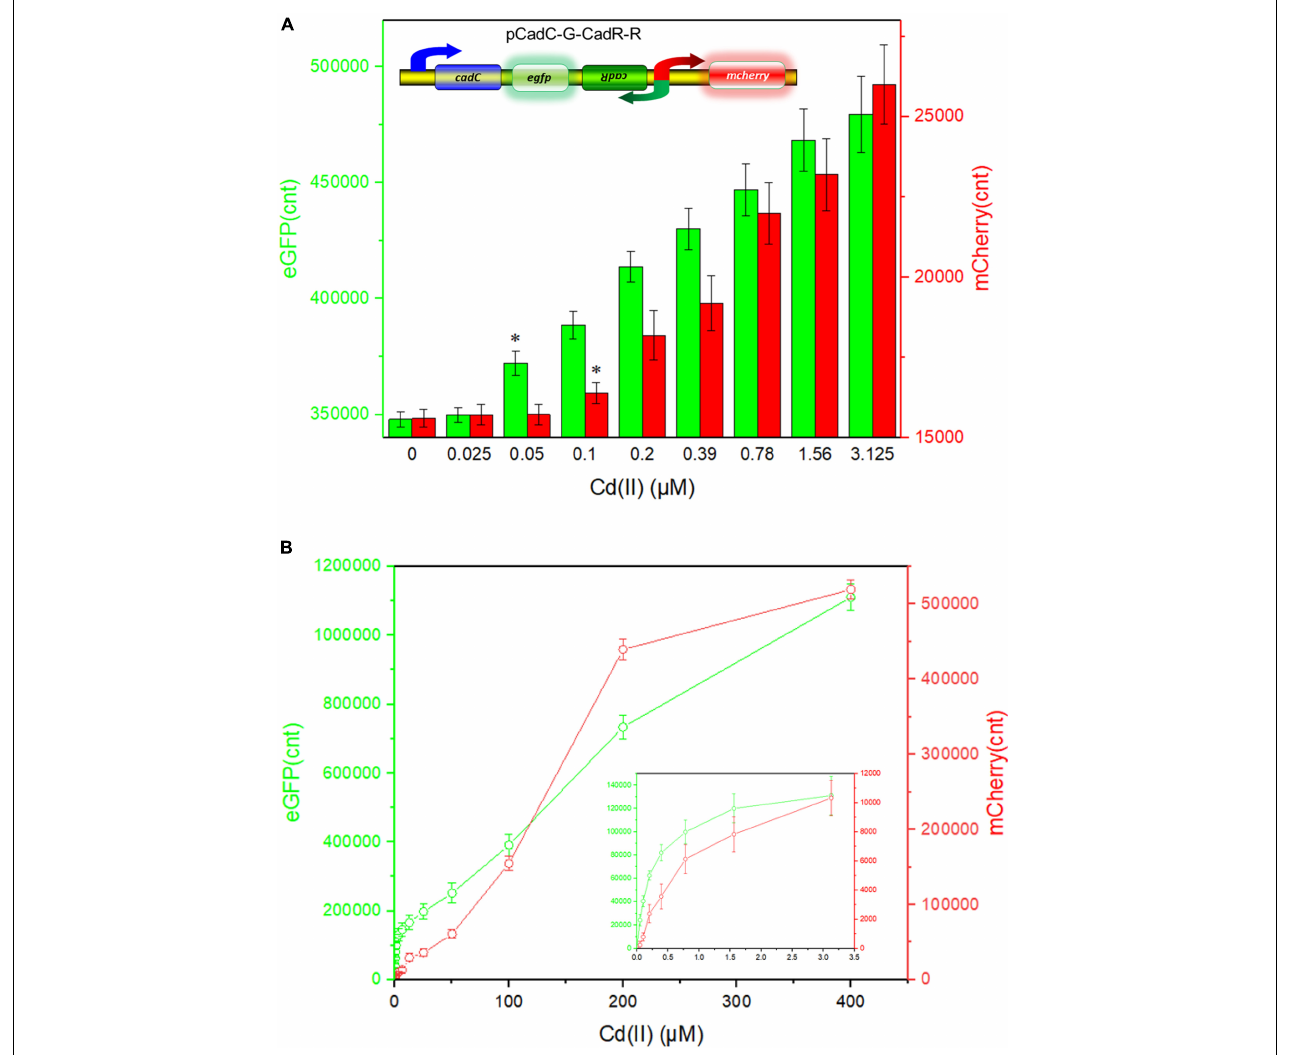
FIGURE 8 | Double-color fluorescence generated by the dual-sensing biosensor after exposure to gradient concentrations of Cd(II). Both fluorescent signals were determined after a 12-h incubation with gradient concentrations of Cd(II) at 37 ◦ C. The fluorescent signal was indicated as a fluorescence count value (unit = cnt), and fluorescence intensity values were normalized using the absorbance at 600 nm. Results are the average of at least three independent experiments performed in triplicate. (A) Detection limit of the dual-sensing biosensor TOP10/pCadC-G-CadR-R. The asterisk indicates a significant increase (two-tailed t -test, P < 0.001 for eGFP and P < 0.05 for mCherry) in fluorescent intensity, in comparison to the same biosensor exposed to 0 µ M Cd(II). (B) Response curves of the dual-sensing biosensor TOP10/pCadC-G-CadR-R in response to different Cd(II) concentrations. The data values shown for each metal exposure group were obtained by subtracting the control values (with no metal exposure) from the experimental